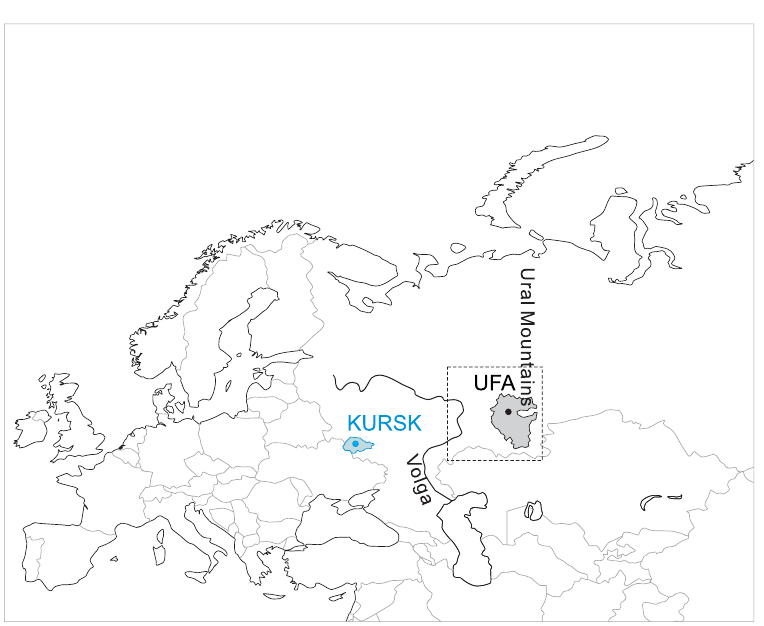
Figure 1. Source regions of the studied populations in the context of the Eurasian continent. KURSK and UFA (circles) are the capitals of the Kursk Region (KR, blue area) and the Republic of Bashkortostan (RB, grey area), respectively. The Volga-Ural Region (VUR, dashed block) is the area between the Volga River and the Ural Mountains. The figure created in CorelDRAW version 13.0.0.739 available at